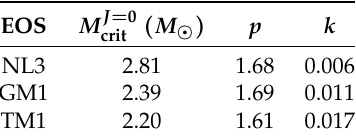
Table 3. Critical NS mass in the non-rotating case and constants k and p needed to compute the NS critical mass in the non-rotating case given by Equation (6). The values are for the NL3, GM1 and TM1 EOS. ( M (cid:12) ) p k EOS M J = 0 crit NL3 2.81 1.68 0.006 GM1 2.39 1.69 0.011 TM1 2.20 1.61